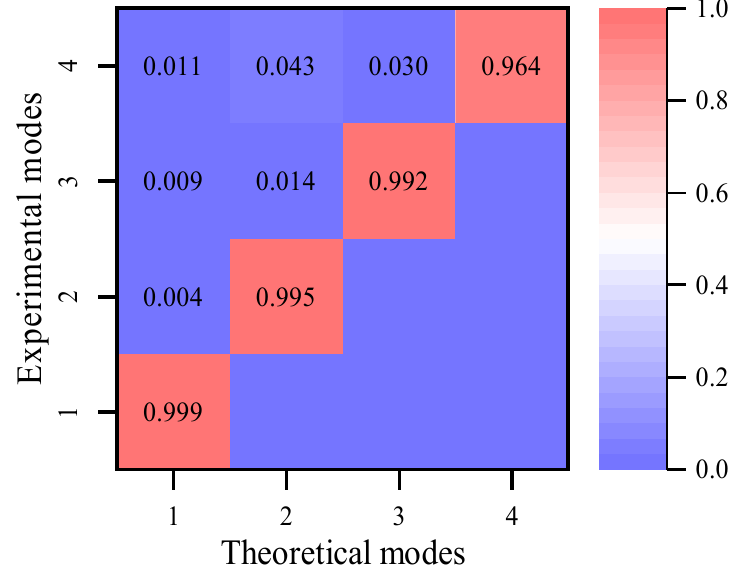
Figure 13. MAC after time lag correction.